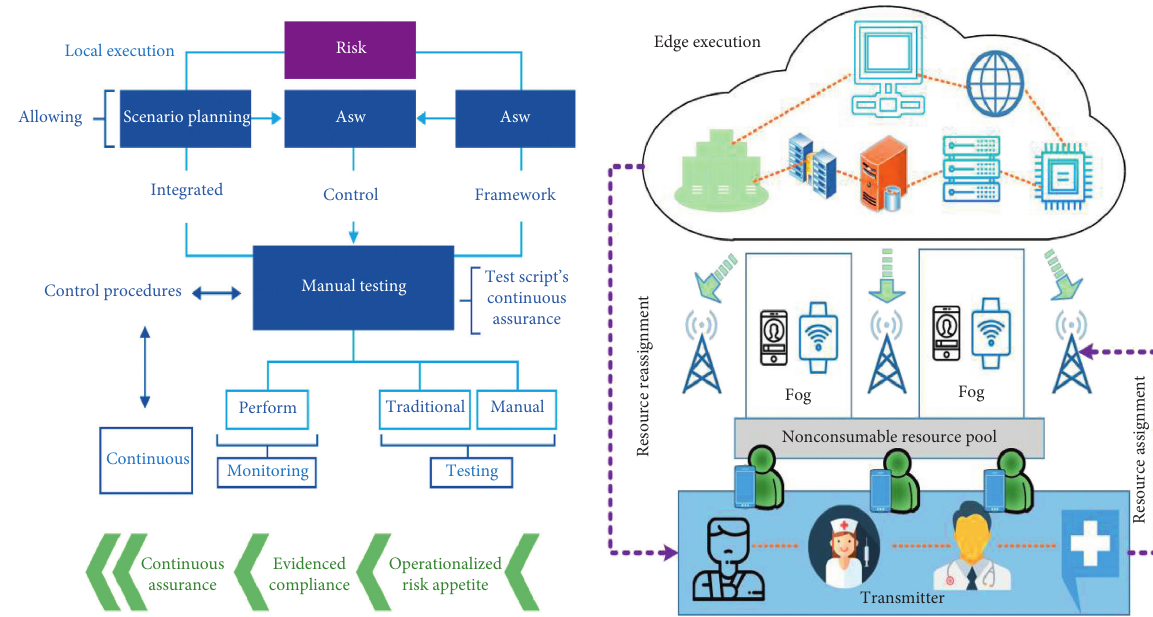
Figure 2: Full and partial